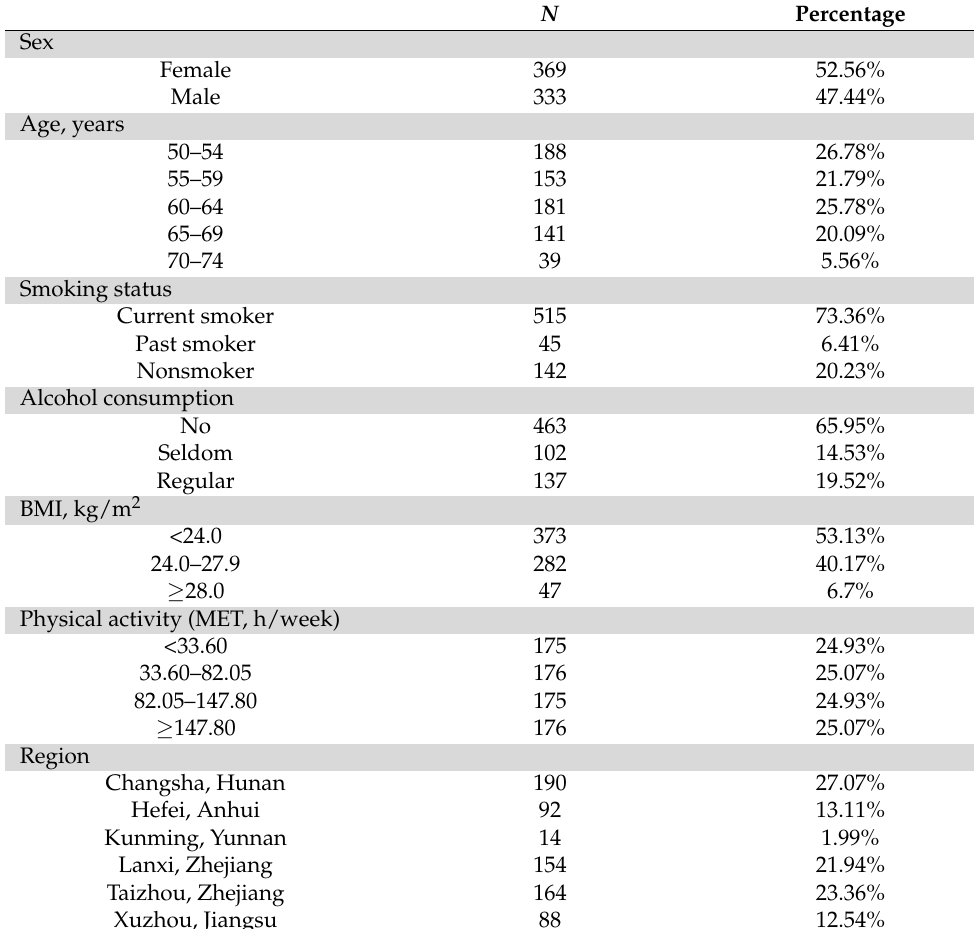
Table 1. Characteristics of the study population ( N = 702).